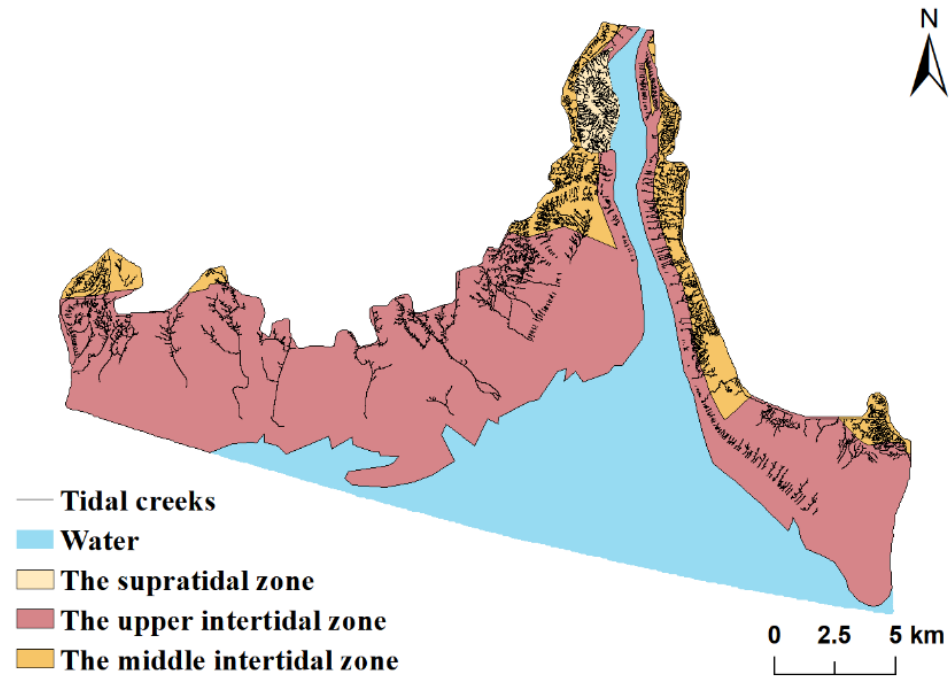
Figure 5. The overlay map of tidal creek extraction and tidal zone